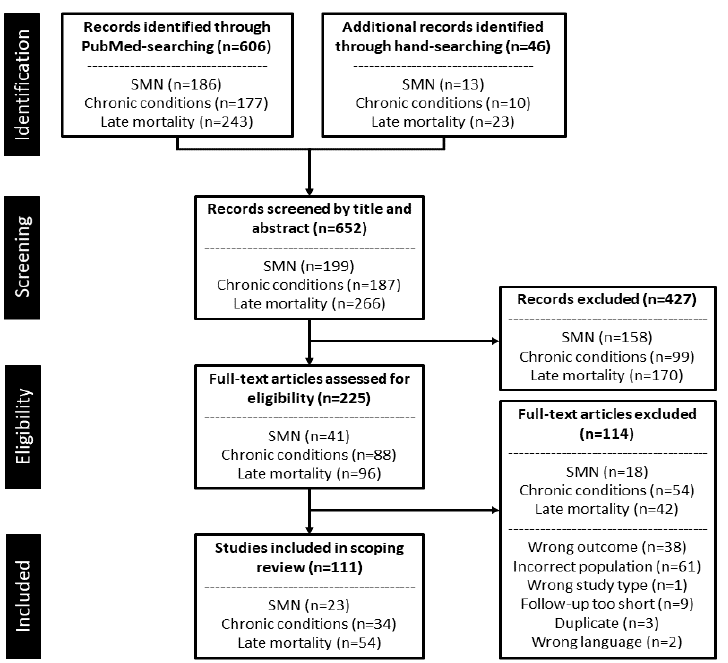
Figure 1. PRISMA flow diagram for the study selection process. Abbreviations: SMN, subsequent malignant neoplasm.